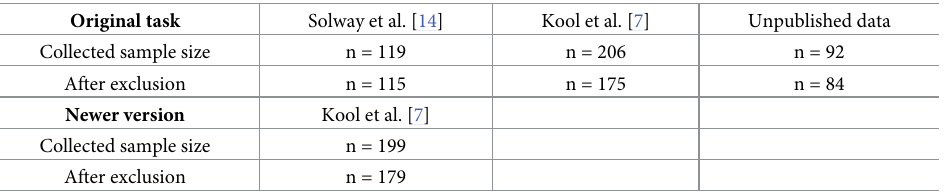
Table 1. Sources and sample sizes of the four